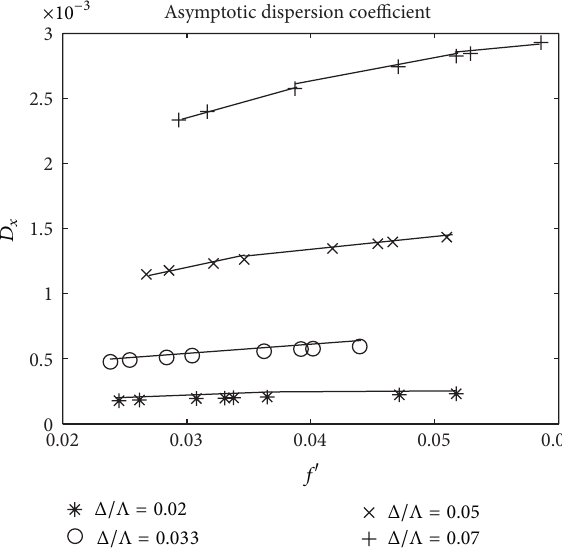
Figure 6: Effect of Froude number on the free surface relative drop.